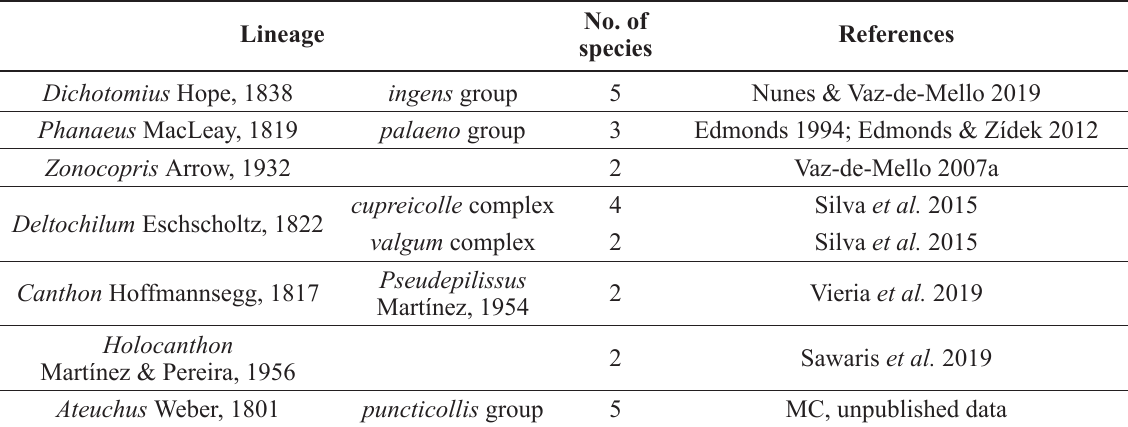
Table 3. Dung beetle lineages endemic to the South American Dry